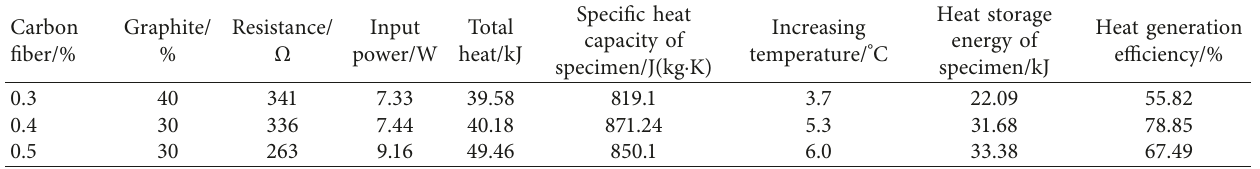
Table 15: Heating efficiency of track board.